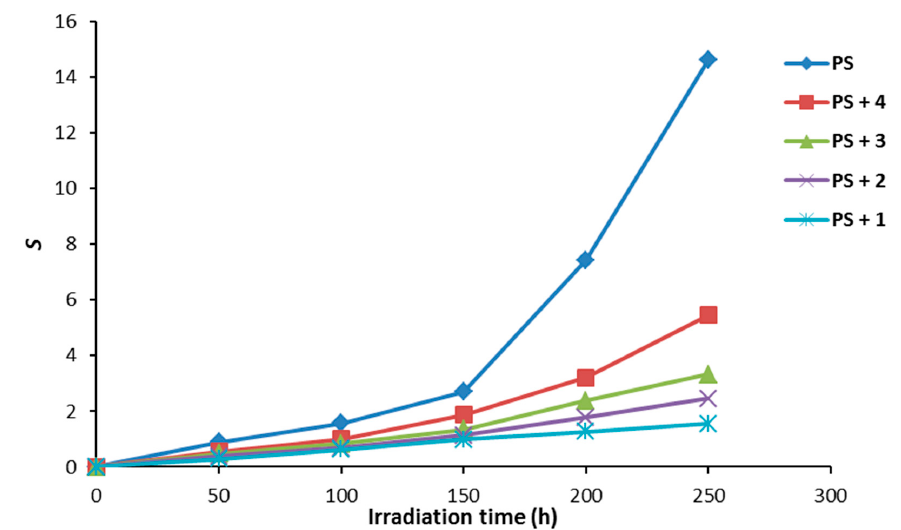
Figure 8. The effect of irradiation on the main chain scissions ( S ) for PS films.